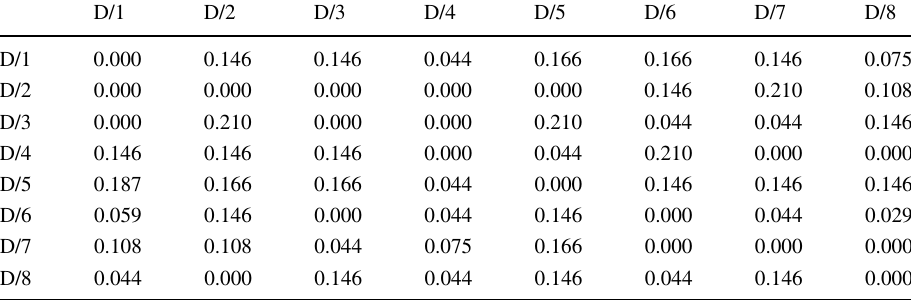
Table 7 Normalized